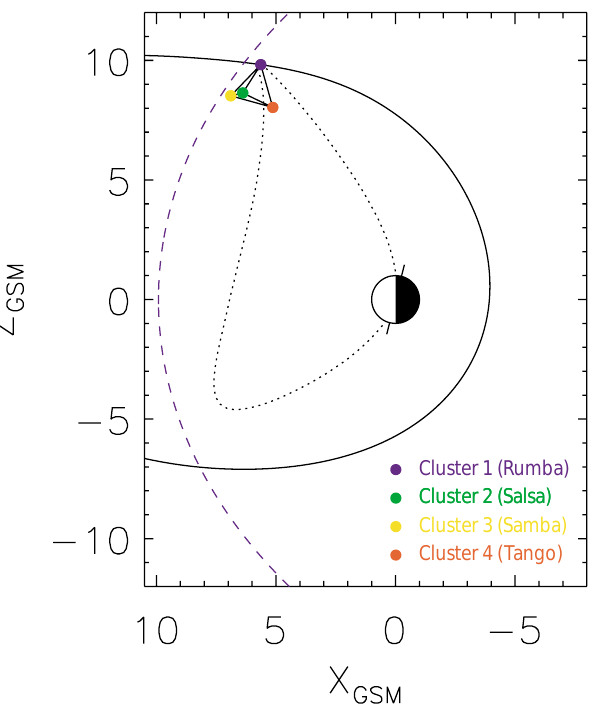
Fig. 2. Plot showing the projection of the orbit of the Cluster 1 (Rumba) spacecraft on to the GSM X − Z plane during the inter- val 14:00 UT on 13 February 2001 to 18:00 UT on 14 February 2001. The relative locations of the four spacecraft at 10:20 UT on 14 February are indicated by coloured circles, as described by the key, where the separation from Cluster 1 has been magnified by a factor of 20, in order to more clearly demonstrate the tetrahedral formation. This time also corresponds the Northern Hemisphere map presented in Fig. 1. A Tsyganenko-96 model field line, as de- scribed in the text, has been drawn from the location of the Clus- ter 1 spacecraft (black dotted line). In addition, a cut through the model magnetopause at Y GSM ≈ 3 . 9 R E (the approximate loca- tion of Cluster 1 at 10:20 UT) is indicated by the dashed blue line, whilst the orientation of the Earth’s magnetic dipole is indicated by the short black